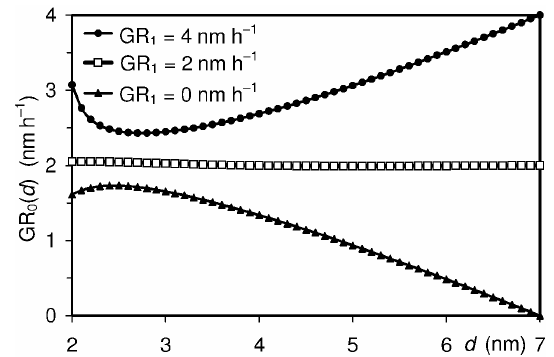
Fig. 3. Growth rate of neutral nanoparticles GR 0 ( d ) in case of the near-median distribution of intermediate ions in Tartu (Fig. 1) and N 50–500 = 2000 cm –3 calculated according to Eq. (9) at the assumption GR 0 (7 nm) = GR 1 for the trial values of charged nanoparticle growth rate GR 1 .